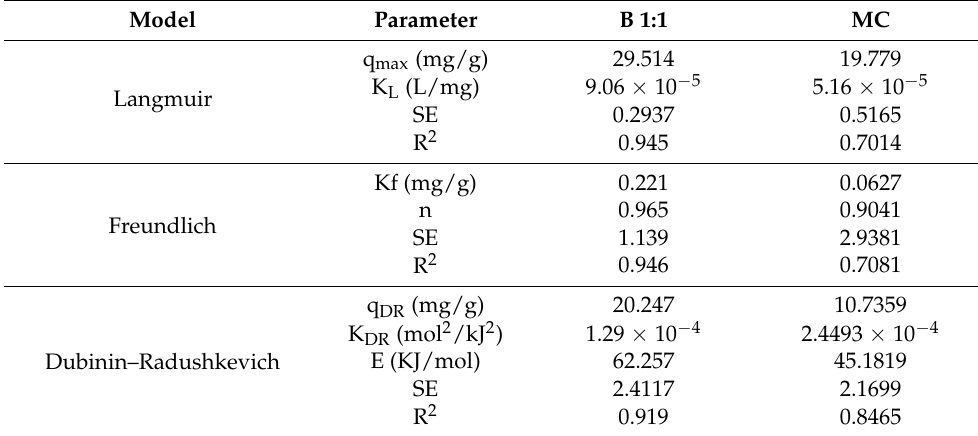
Figure 4. Isothermal sulfate adsorption on ( a ) B 1:1 and ( b ) MC. Table 6. Adjustment parameters of sulfate adsorption